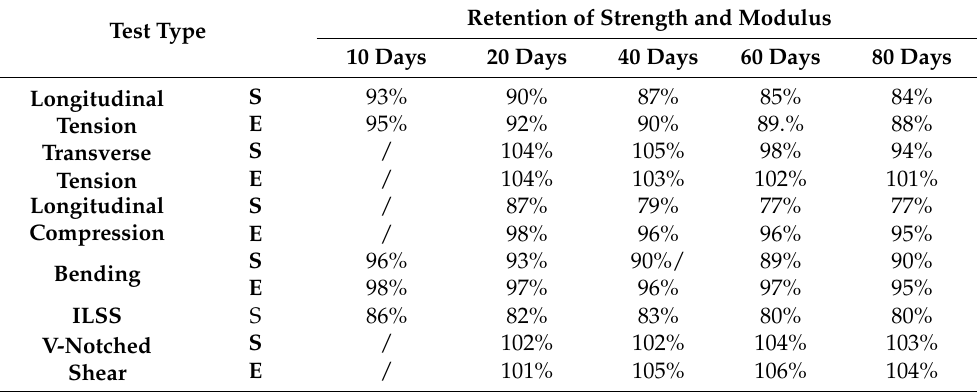
Table 3. Macromechanics of CFRP pre- and